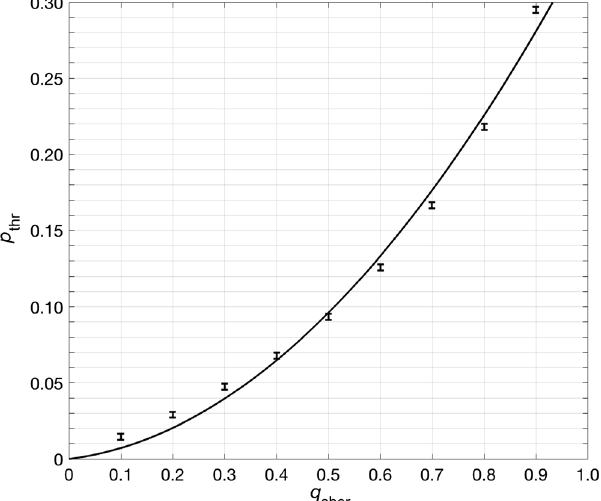
FIG. 6. Scaling of the estimated threshold p with respect to the Shor density q . The fit is quadratic through the origin; the shor finite-size effects are apparent. All points were obtained on 81 × 81 -size lattices, except for q 0 . 9 . To emphasize finite- shor ¼ size effects, this was performed on a 631 × 631 lattice, which is greater than necessary for fault-tolerant computation